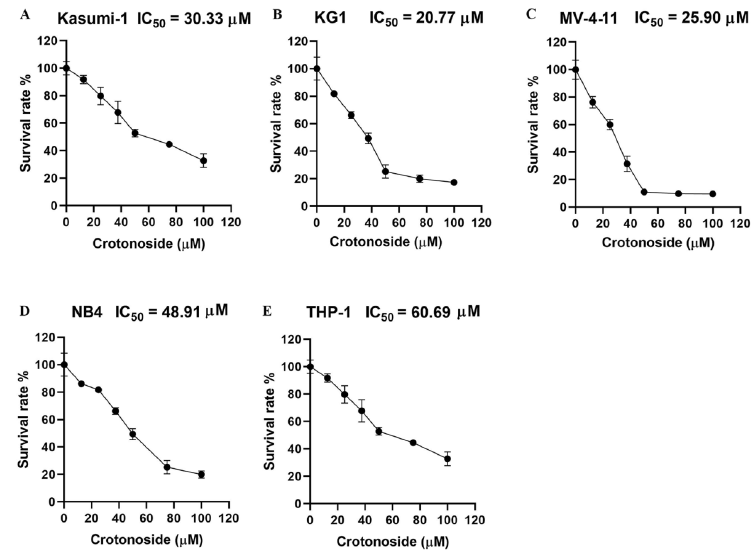
Figure 7. The viability inhibitory activity of crotonoside against different AML cells: ( A ) Kasumi-1, ( B ) KG-1, ( C ) MV-4-11, ( D ) NB4, and ( E ) THP-1 cells were treated with different concentrations of crotonoside for 48 h, and 0.1% DMSO was used as control. The cell viability was inhibited in a dose-dependent manner. All the data are presented as means ± SD from three independent experiments. 2.7. Crotonoside Can Reverse the Highly Expressed ABOBEC3G in KG1 Cells The endogenous mRNA expression levels of APOBEC3G in the four non-M3 AML cell lines were assayed by qPCR. The expression level was relatively higher in KG-1 cells than in others (Figure 8A). Next, we evaluated the expression of all the members of the APOBEC3 family in KG-1 cells with or without crotonoside. RNA transcriptome sequenc- ing of KG-1 showed that the APOBEC3G was the most highly expressed and the APO- BEC3D/F/G were relatively highly expressed, while the other members showed much lower expressions (Figure 8B). Exposing to crotonoside at the concentration of 20 μ M, the high expression level of APOBEC3D/F/G was reversed dramatically. The qPCR result con- firmed it again, when the KG-1 cells were treated with crotonoside at the concentration of 20 μ M, the expression of APOBEC3G was decreased (Figure 8C). Therefore, crotonoside can reverse the high expression of APOBEC3G, and this result is in agreement with the molecular docking simulations, indicating that APOBEC3G may be a potential target of crotonoside.